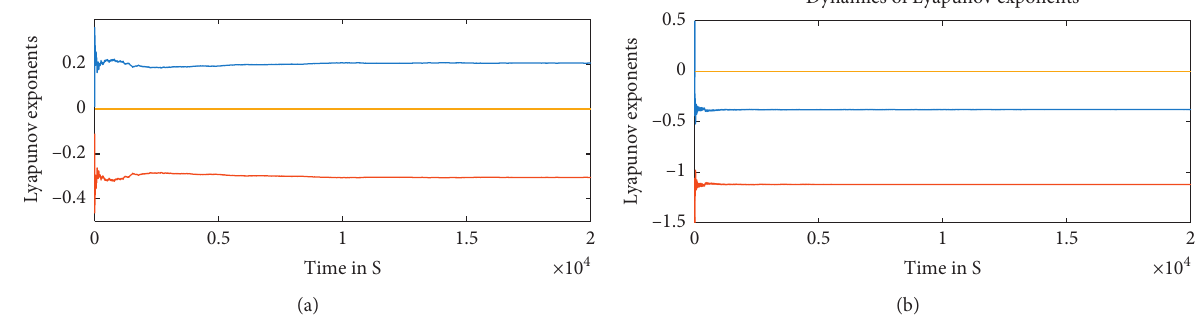
Figure 3: Lyapunov exponents. (a) For η � 0 . 1 and initial condition of [0.6, 0]; (b) for η � 1 . 5 and initial condition of [0.5,